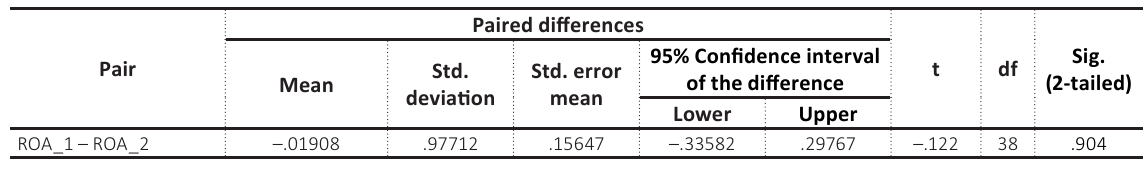
Table A15. Paired samples correlations (the result of H4b ) Pair Table A16. Paired samples test (the result of H4b